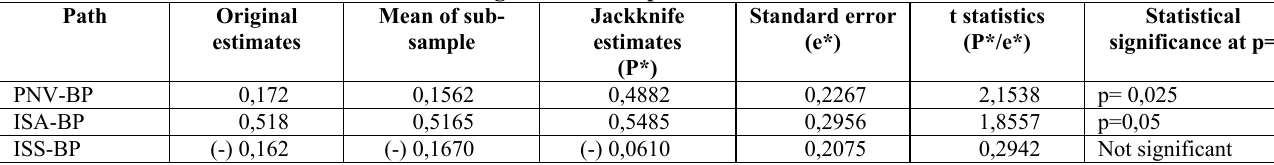
Table 6: Jackknife estimates and statistical significance for paths Path